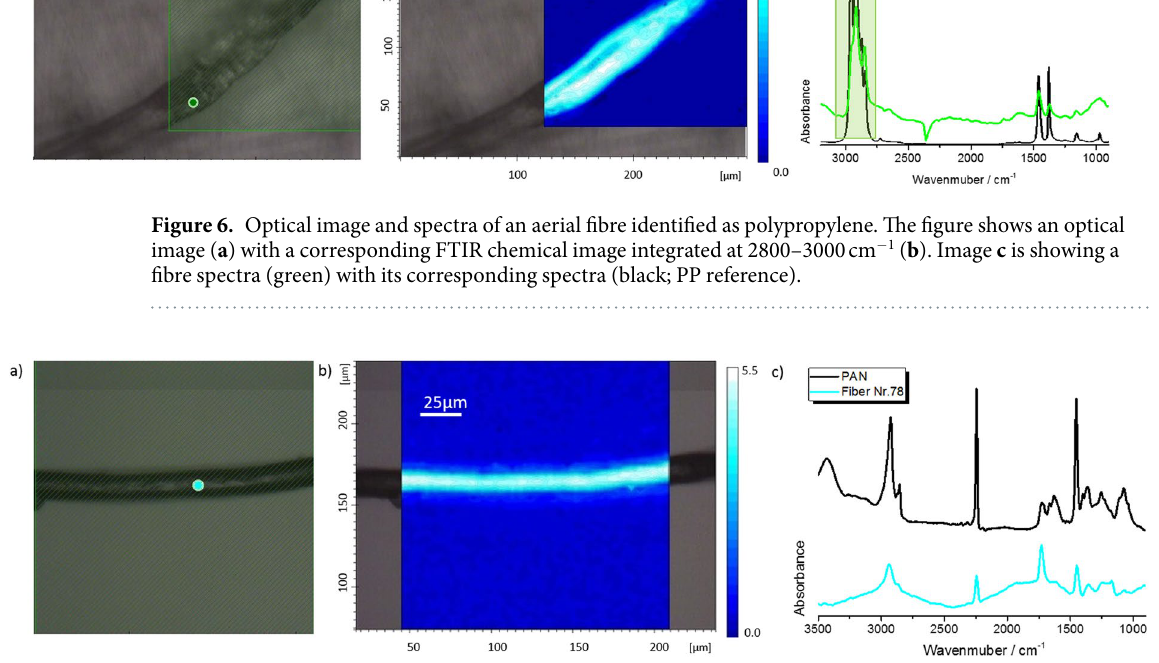
Figure 7. Optical image and spectra of an aerial fibre identified as polyacrylonitrile. The figure shows an optical image of a microfibre ( a ) with its corresponding FTIR chemical image ( b ), showing the PAN fibre at integration 2200–2300 cm − 1 . Image c shows the PAN reference spectrum (black) and the fibre’s spectrum (light blue).